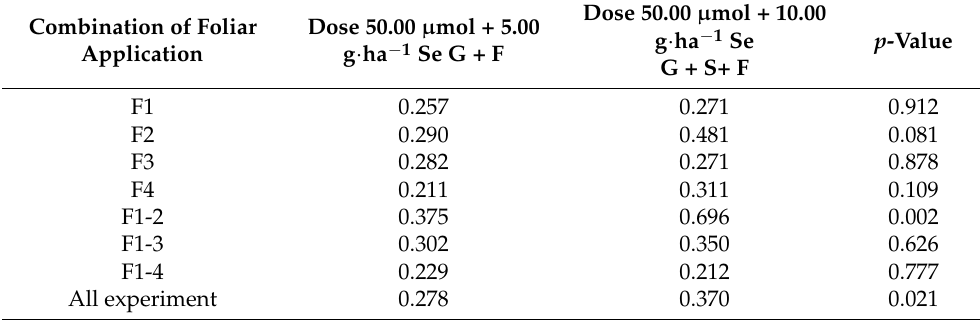
Table 4. Average selenium content in wheat grain depending on dose and phase of foliar